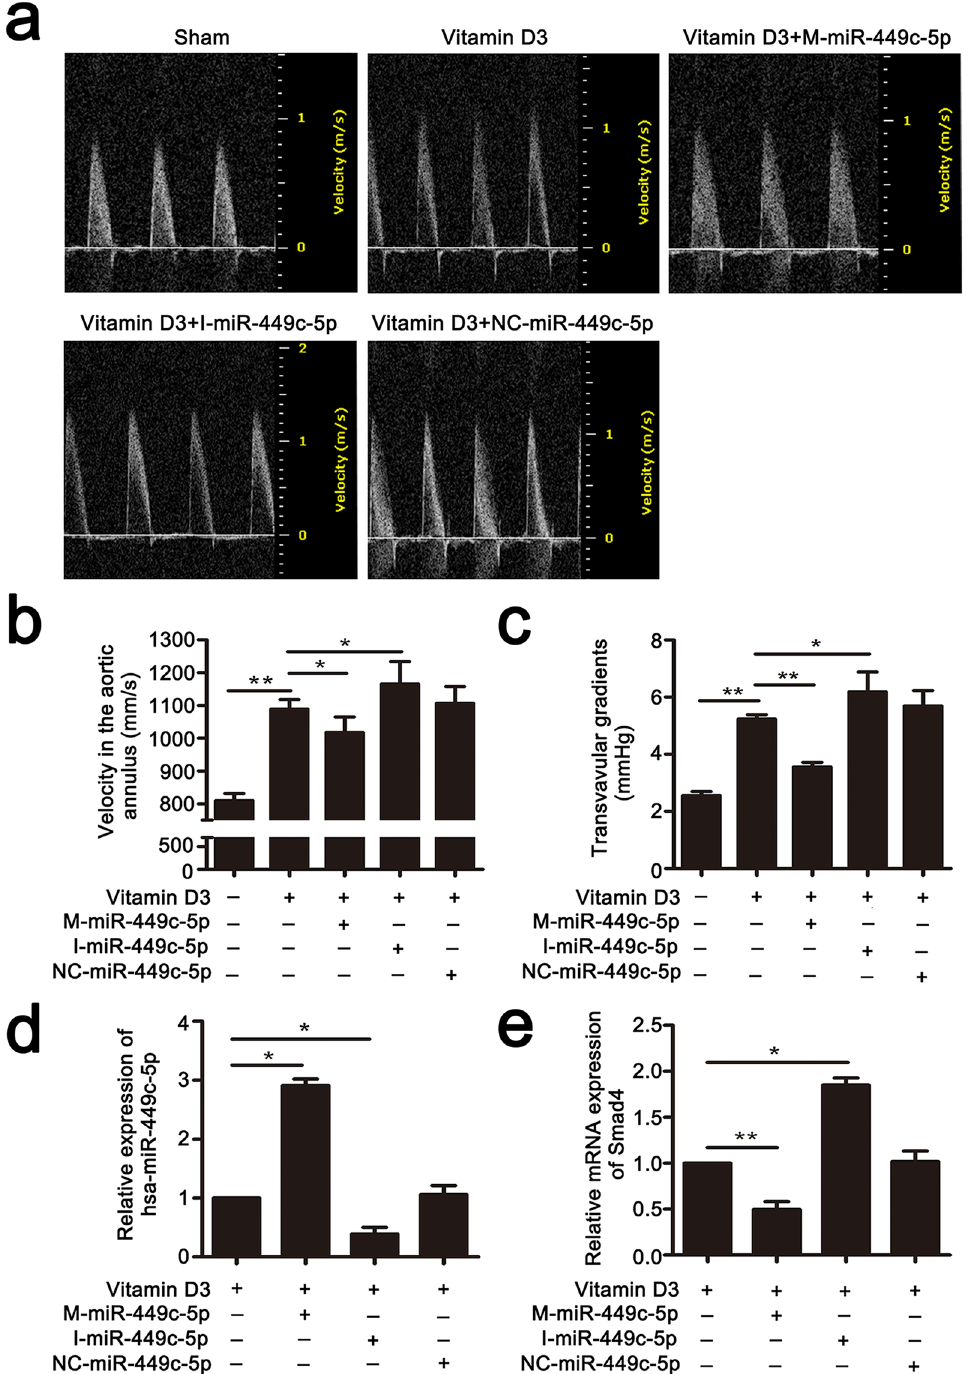
Figure 6. MiR-449c-5p inhibits aortic valve calcification in vivo . ( a ) The velocity profile in the aortic annulus measured by echocardiography six weeks after transfection in vitamin D3-treated mice. ( b ) Quantitative analysis of the velocity in the aortic annulus in each group. ( c ) Quantitative analysis of transvalvular gradients in each group. ( d ) qRT-PCR analysis of miR-449c-5p expression in the aortic valves of mice at day 5. ( e ) qRT-PCR analysis of Smad4 expression level in the aortic valves of mice at day 10. n = 7 in each group. Data are presented as the mean ± SD. * P < 0.05, ** P <